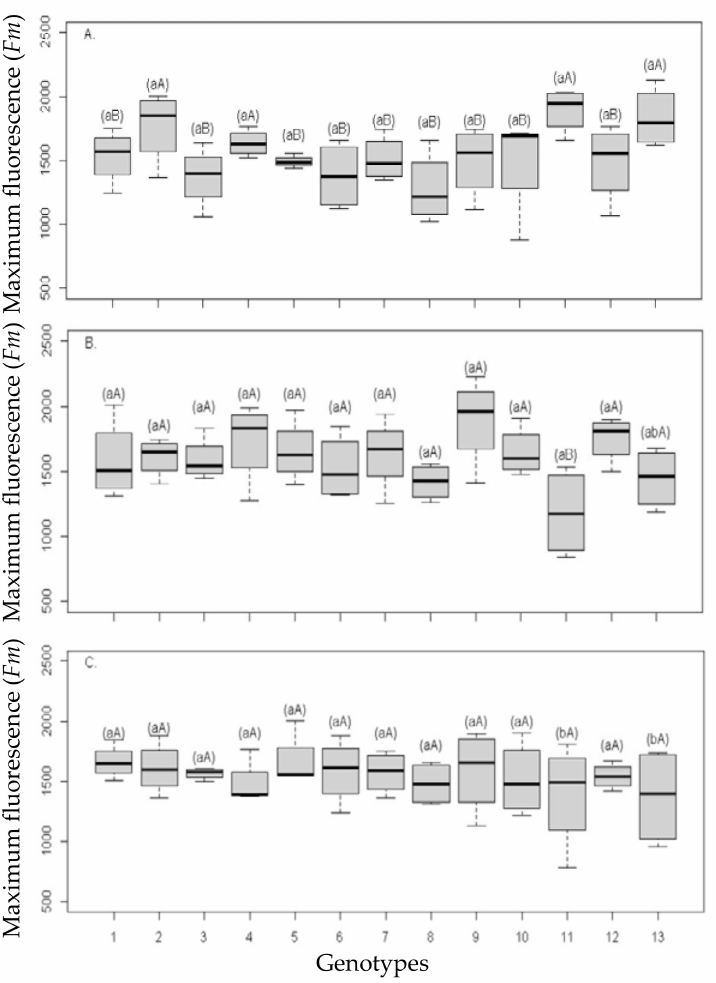
Figure 9. Boxplot relative to the average maximum fluorescence (Fm) of 13 citrus rootstocks in combination with ‘Tahiti’ acid lime ( Citrus × latifolia (Yu. Tanaka) Tanaka) under irrigation with waters of 0.14 ( A ), 2.40 ( B ), and 4.80 dS m − 1 ( C ), in the second year. For identification of genotypes, see Table 1. Boxplots with the same lowercase letter do not differ statistically, according to the Tukey test between salinity levels ( p ≤ 0.05), and those with the same uppercase letter belong to the same genotype group, according to the Scott–Knott test ( p ≤